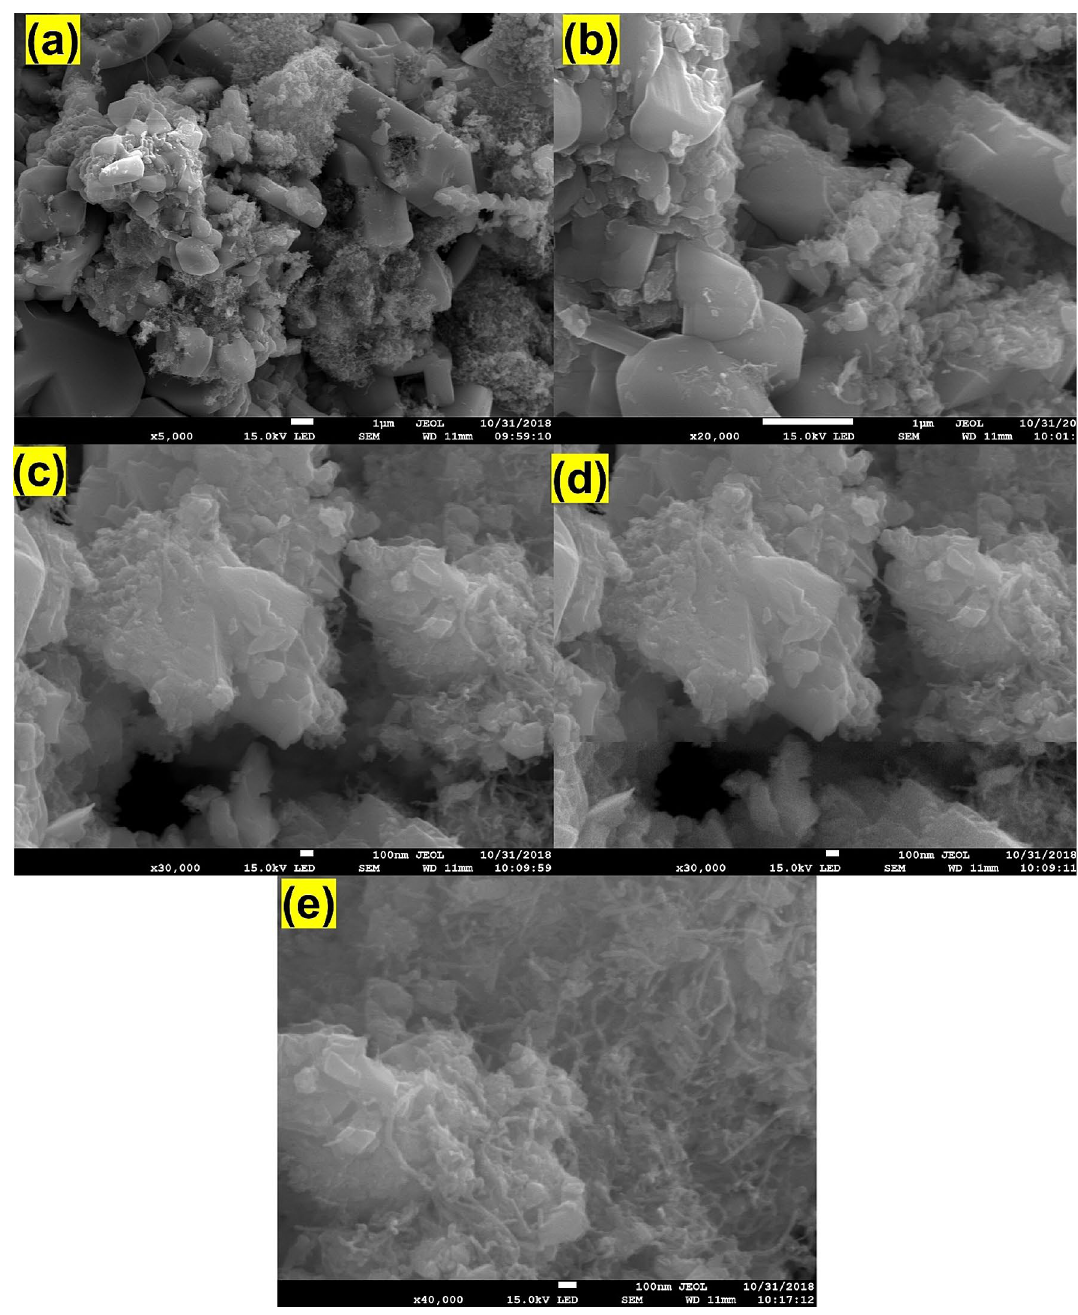
Figure 4. ( a–e ) SEM morphology of the CuO@MnO 2 /N-MWCNT